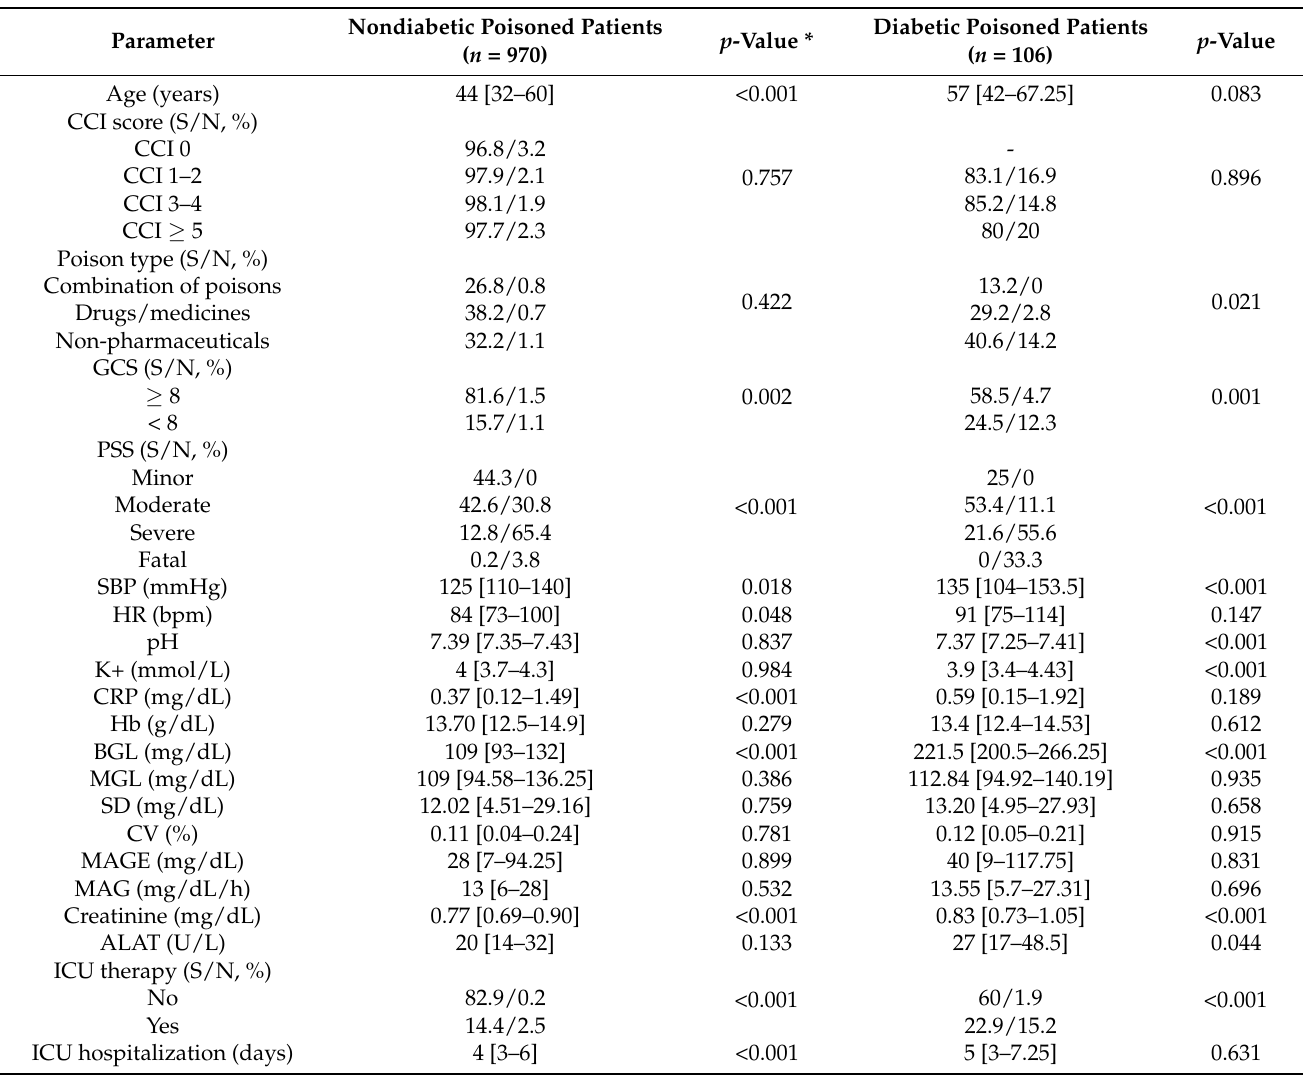
Table 1. Baselines characteristics of the cohort.